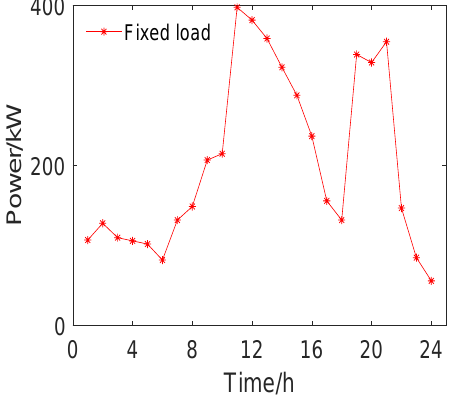
Figure 8. Empirical values of fixed load.